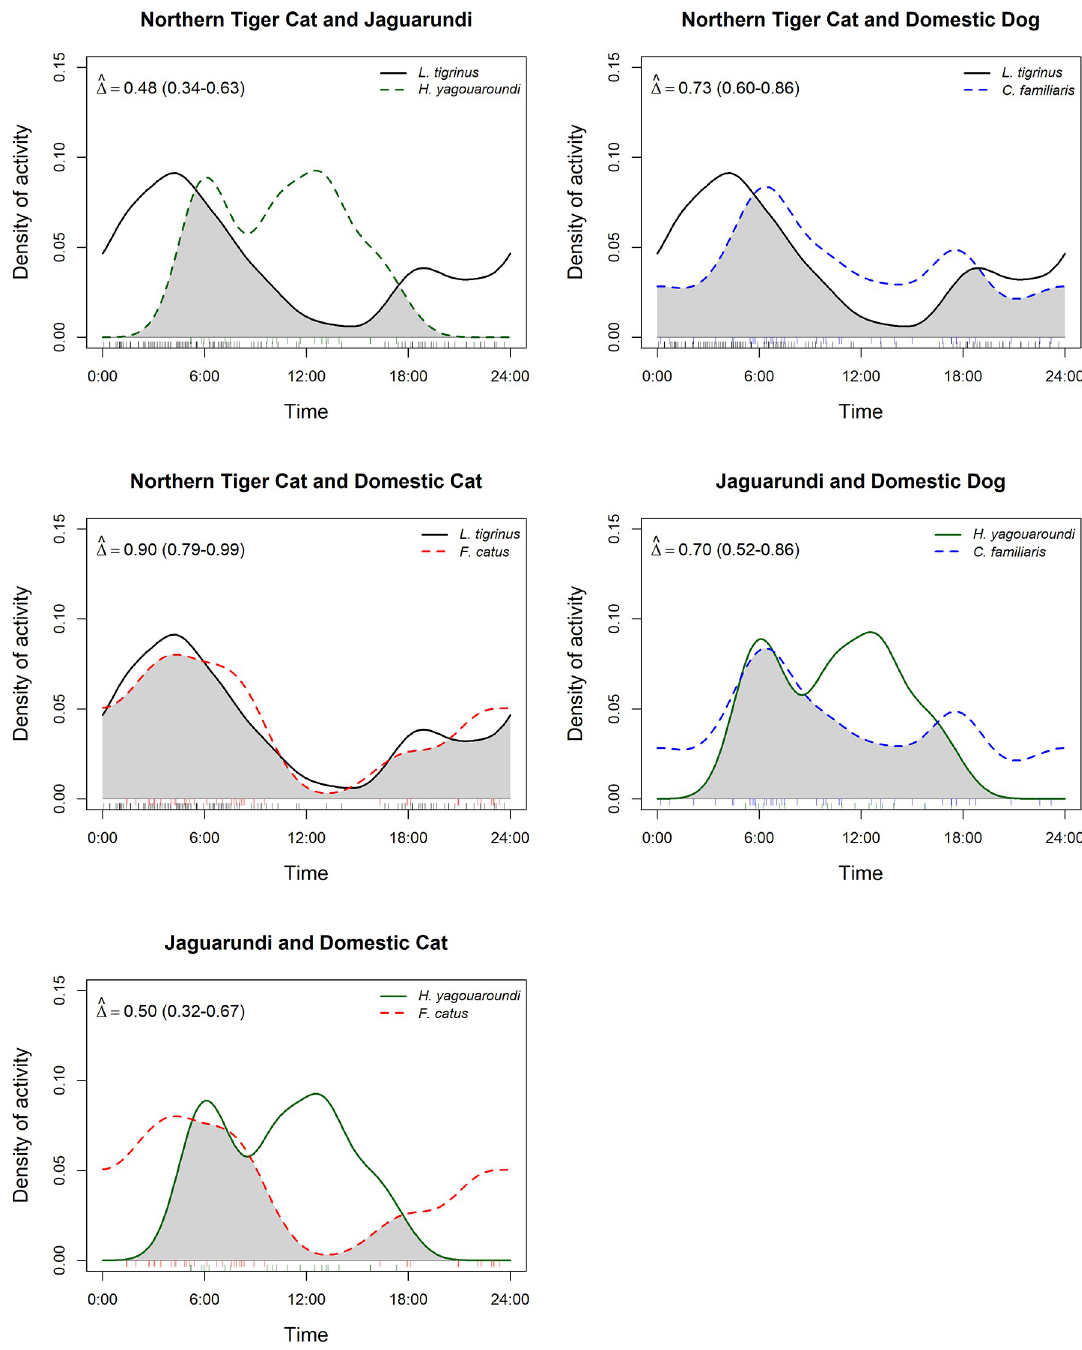
Fig 4. Activity overlap plots among each species